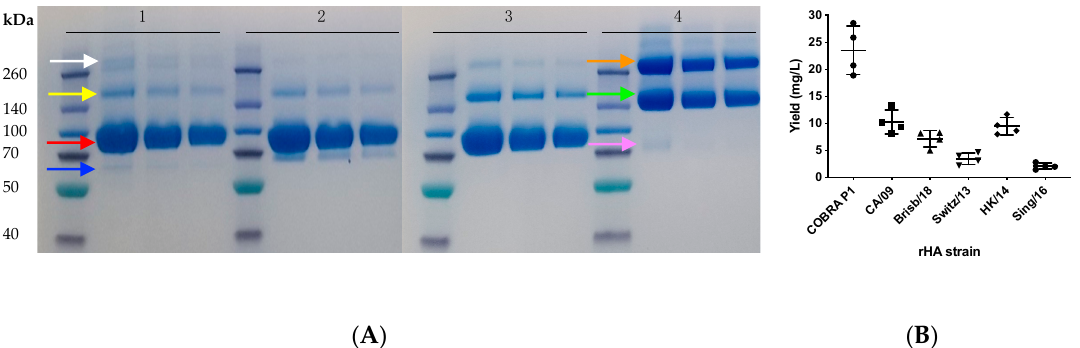
Figure 4. Representative Coomassie stained SDS-PAGE of purified recombinant proteins expressed by stably-transfected cell lines. From left to right in 1, 2, 3 and 4 Spectra Multicolor Broad Range Protein Ladder (Thermo Fisher Scientific), 8, 5 and 3 µg of purified rHA from H3N2 A/Singapore/INFIMH-16-0019/2016 (Sing/16), H1N1 A/New Caledonia/20/99, H1N1 COBRA P1 and rNA from H3N2 TX/12, respectively. For rHA, arrows indicate monomers (red), dimers (yellow) and trimers (white) and a less glycosylated rHA monomer isoform (blue). For rNA, arrows indicate dimers (green), tetramers (orange) and monomers (pink) ( A ). Representative yields from culture media of transfected EXPI293F cell lines stably expressing rHA proteins from H1N1 COBRA P1, CA/09, Brisb/18 and H3N2 Switz/13, HK/14 and Sing/16 ( B ).